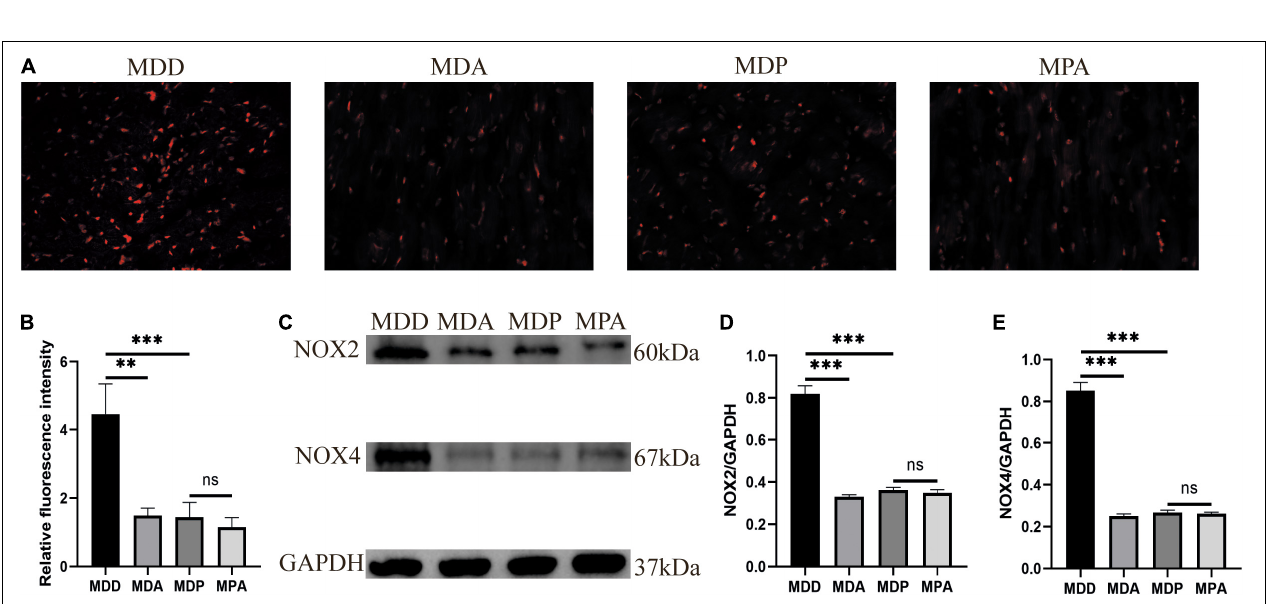
FIGURE 15 | Oxidative stress. (A) Typical images of ROS. (B) Relative fluorescence intensity of ROS, n = 6 per group. (C) Immunoblotting of NOX2 and NOX4. (D,E) Quantitative analyses of NOX2 and NOX4, n = 5 per group. ** p < 0.01, *** p < 0.001 vs. MDD; ns, no significance.